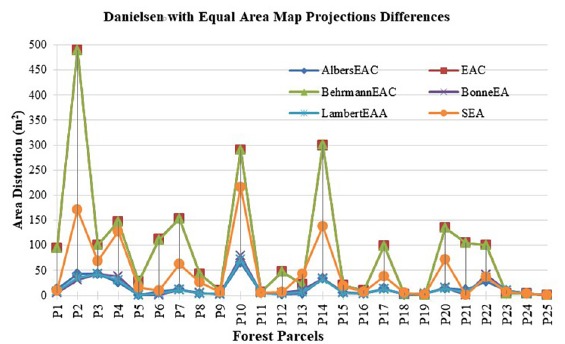
Figure 4. Danielsen ellipsoid geographical area with Equal area projection